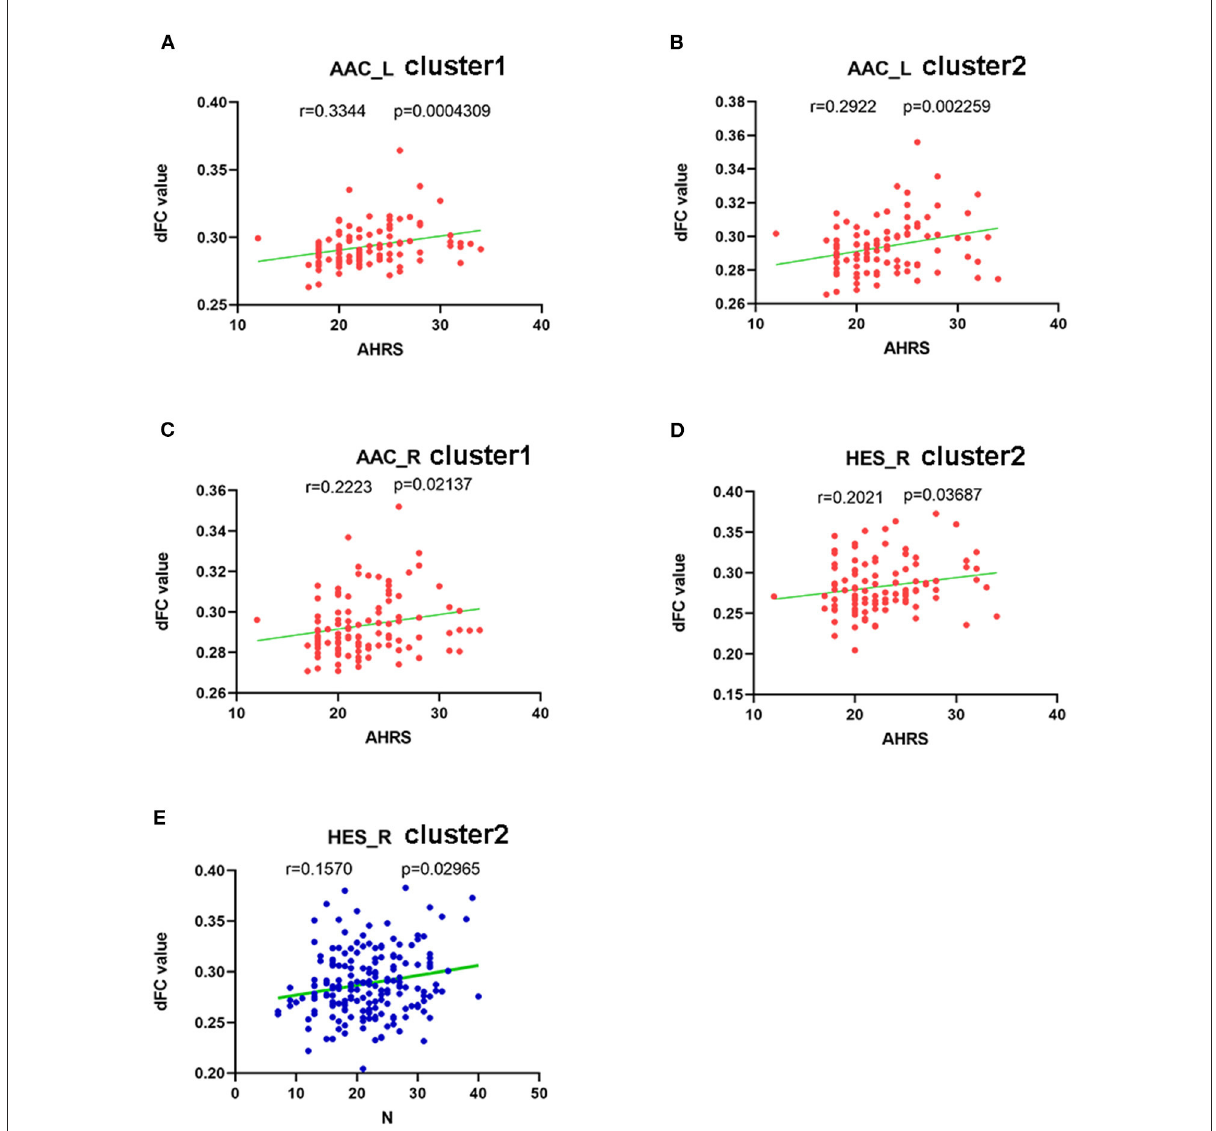
FIGURE4 Correlations between abnormal dFC values and clinical variables. In schizophrenia patients with AVH. (A) a positive correlation was observed between the dFC values in the cluster1 using left AAC as seed and AHRS. (B) a positive correlation was observed between the dFC values in the cluster2 using left AAC as seed and AHRS. (C) a positive correlation was observed between the dFC values in the cluster1 using rihgt AAC as seed and AHRS, and (D) a positive correlation was observed between the dFC values in the cluster2 using right HES as seed and AHRS. In schizophrenia patients with AVH and NAVH. (E) a positive correlation was observed between the dFC values in the cluster2 using right HES as seed and PANSS negative